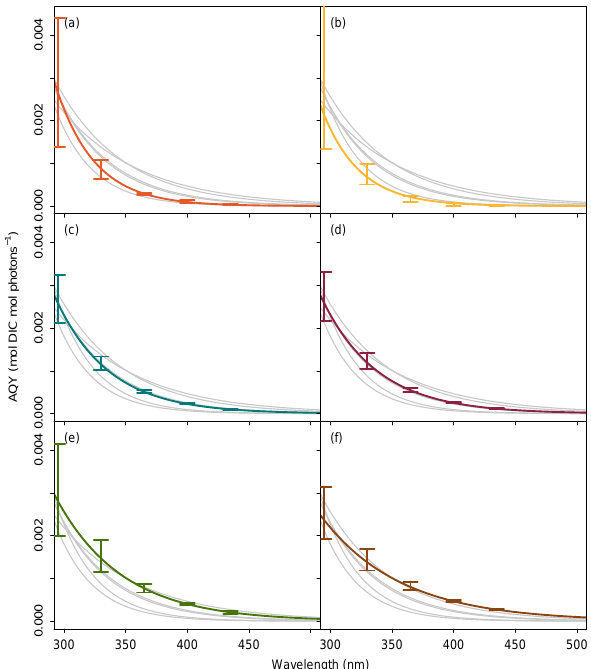
Figure 2. Apparent quantum yield (AQY) spectra for (a) June, (b) July, (c) August, (d) September, (e) October and (f) November, in- cluding simultaneous pointwise 95% confidence intervals at 295, 330, 365, 400 and 435nm. For comparison, the AQY spectra of the other months are added in grey in each